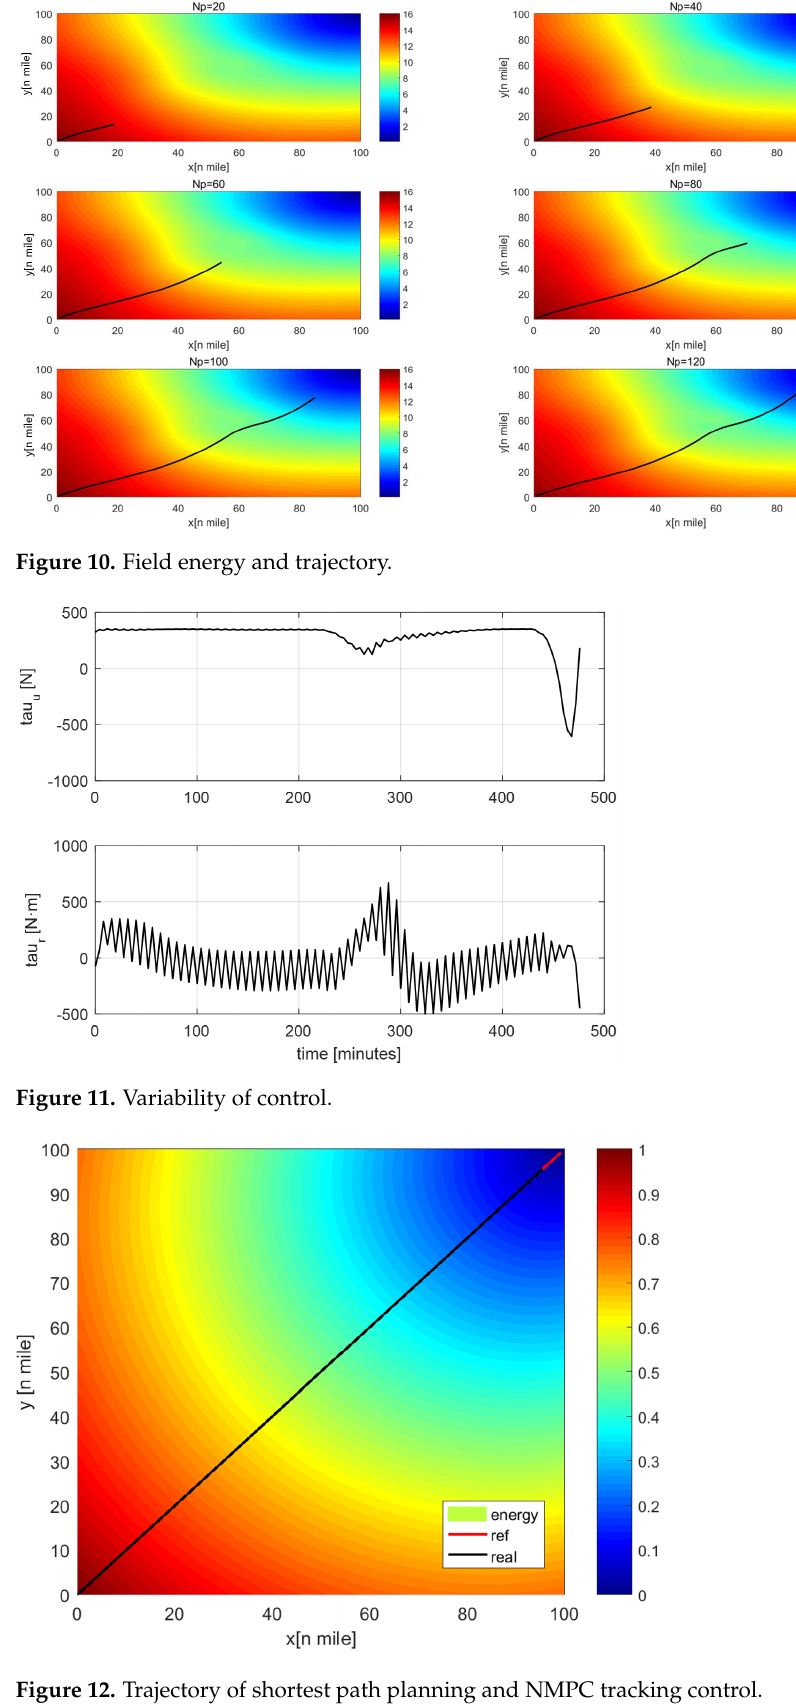
Figure 12. Trajectory of shortest path planning and NMPC tracking